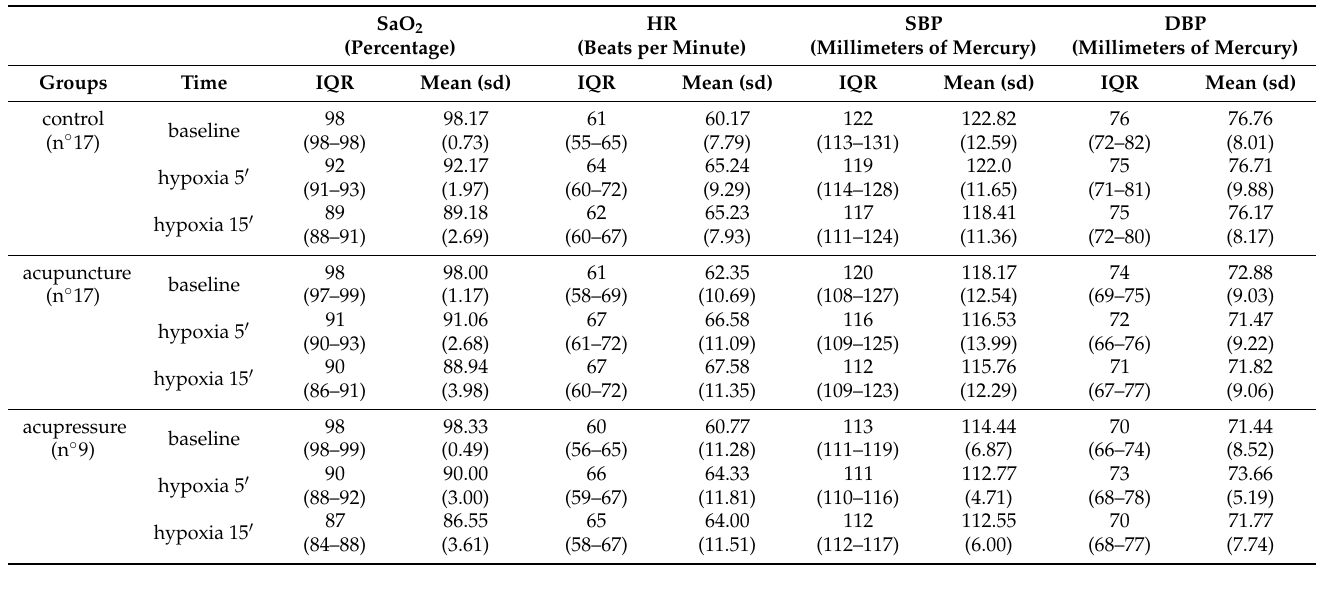
Table 1. Interquartile ranges (IQR), mean and standard deviation (sd) of oxyhaemoglobin saturation (SaO 2 ), heart rate (HR), systolic and diastolic blood pressure (SBP and DBP) in controls, acupuncture and acupressure groups at baseline and after 5 and 15 min of hypoxia.